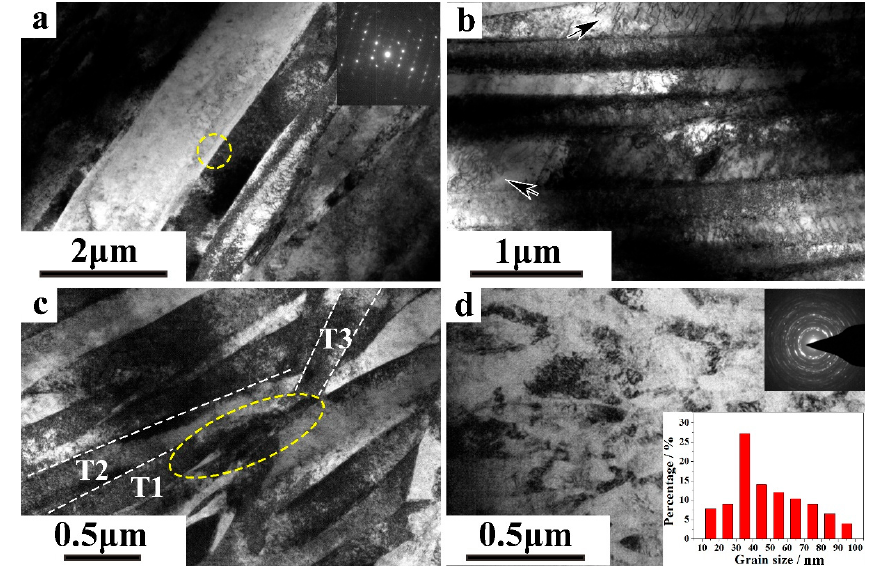
Figure 3. TEM images of representative microstructures at different regions through the depth of the RASP-processed Ti: ( a , b ) monosystem twinning and high density dislocation structures in the core region, ( c ) multisystems twinning in the twin transition region, and ( d ) nano-/ultrafine grains in the nanostructured region, corresponding grain size distribution reveals that an average grain size of ~50 nm is fabricated in Ti.